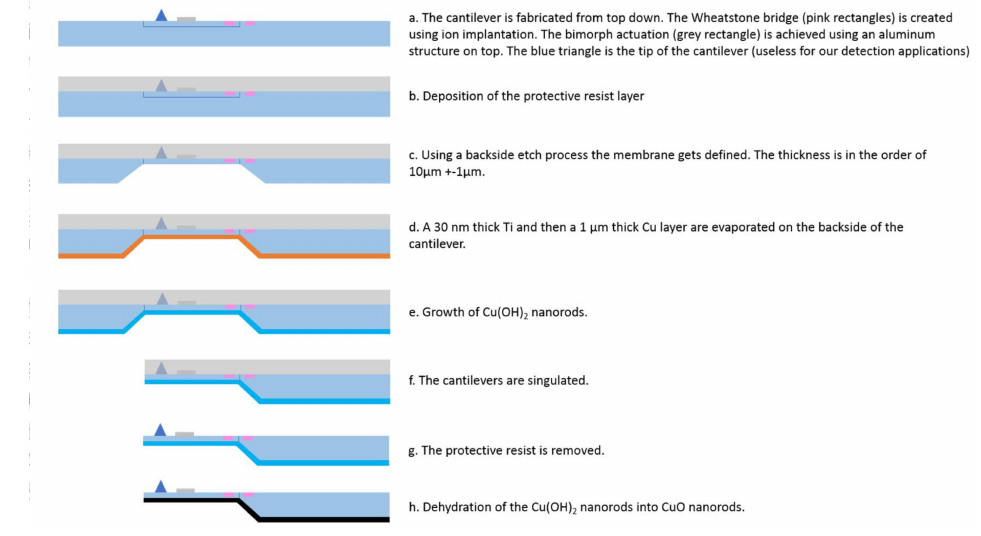
Figure 1. Fabrication process of the nanostructured piezoresistive